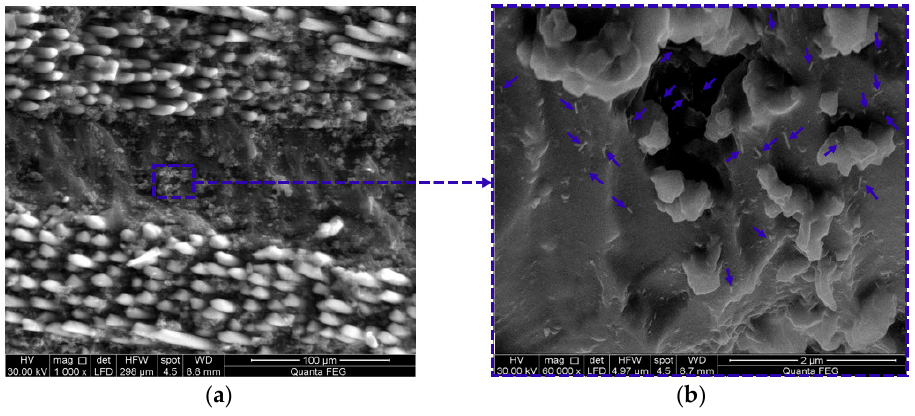
Figure 4. FESEM images for ( a ) 2.0 wt % MWCNTs/GFRP coupon and ( b ) a close view of well-dispersed 2.0 wt % MWCNTs in epoxy matrix and the blue arrows mark some of the embedded MWCNTs.